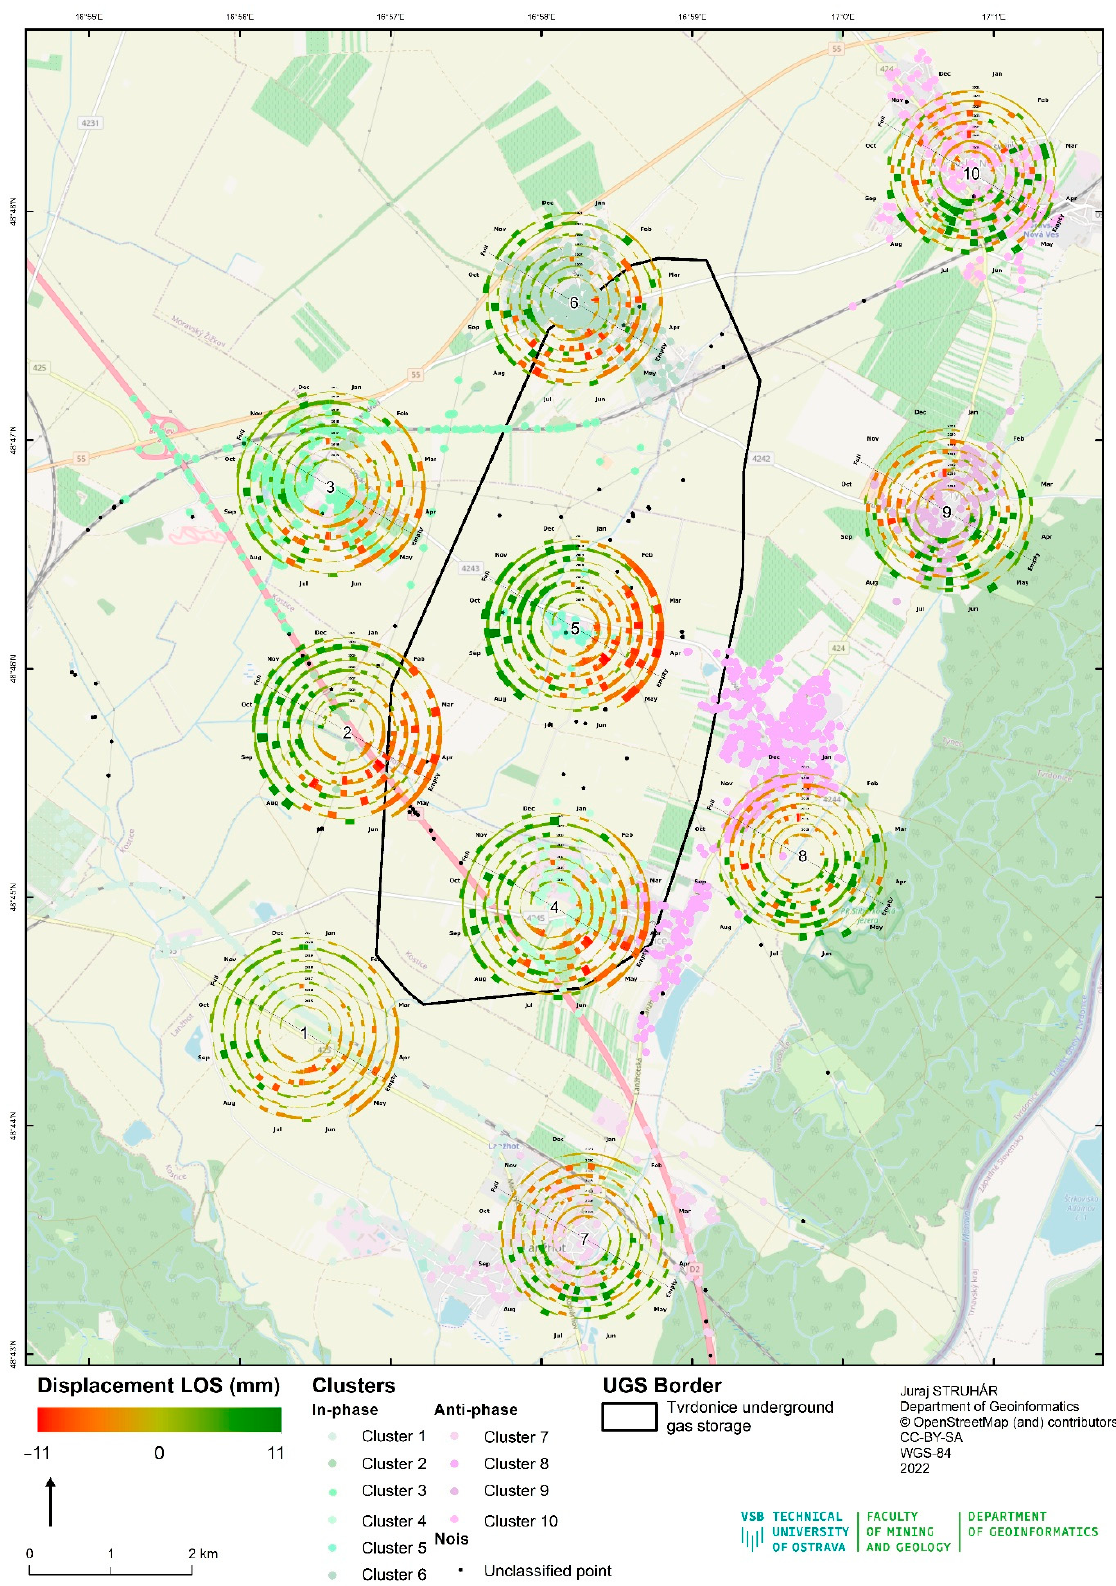
Figure A3. Map composition depicting the distribution of spiral graphs over cluster centroids in the form of the diagram map.